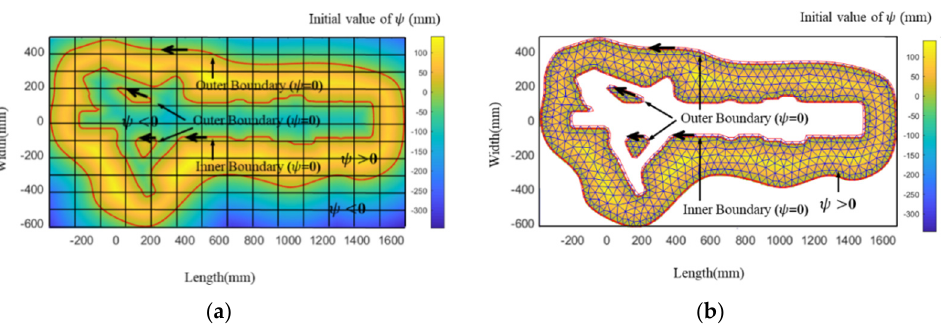
Figure 4. Solution domain and initial value of level set function ψ : ( a ) FDM; ( b ) FEM.